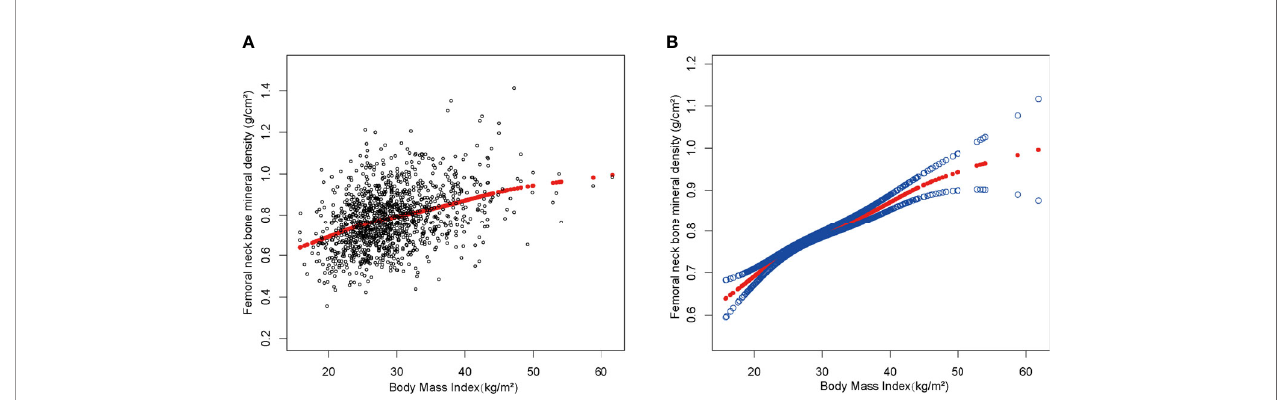
FIGURE 2 | The association between body mass index and femoral neck bone mineral density. (A) Each black point represents a sample. (B) The solid red line represents the smooth curve fi t between variables. Blue bands represent the 95% con fi dence interval from the fi t. Age, gender, race, education level, activities status, diabetes status, NAFLD status, smoking status, ALT, ALP, AST, total calcium, total cholesterol, direct HDL cholesterol, LDL cholesterol, triglyceride, and serum phosphorus were